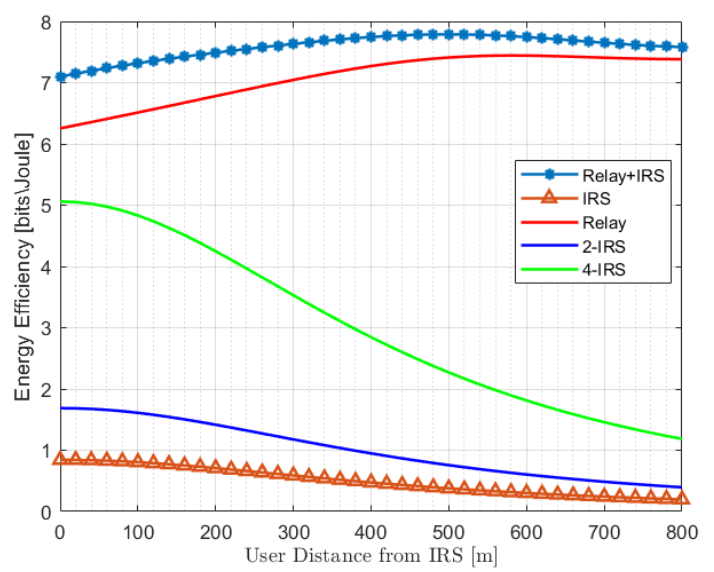
Figure 5. EE versus Distance with multiple IRS